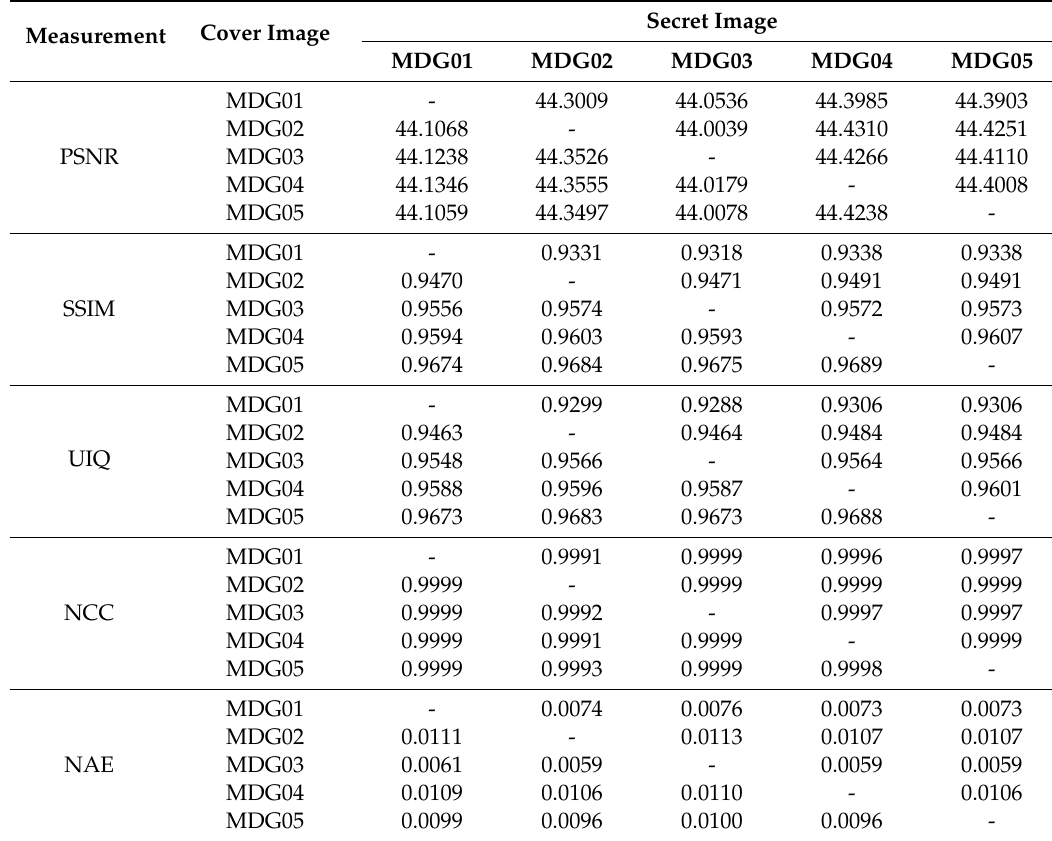
Figure 6. Histogram showing similarity of the secret image MDG09 prior to and after its extraction from the stego image MDG06. Table 2. PSNR, SSIM, UIQ, NCC, NAE, IF, AD, MD, and SC values for colour images used in the experiments